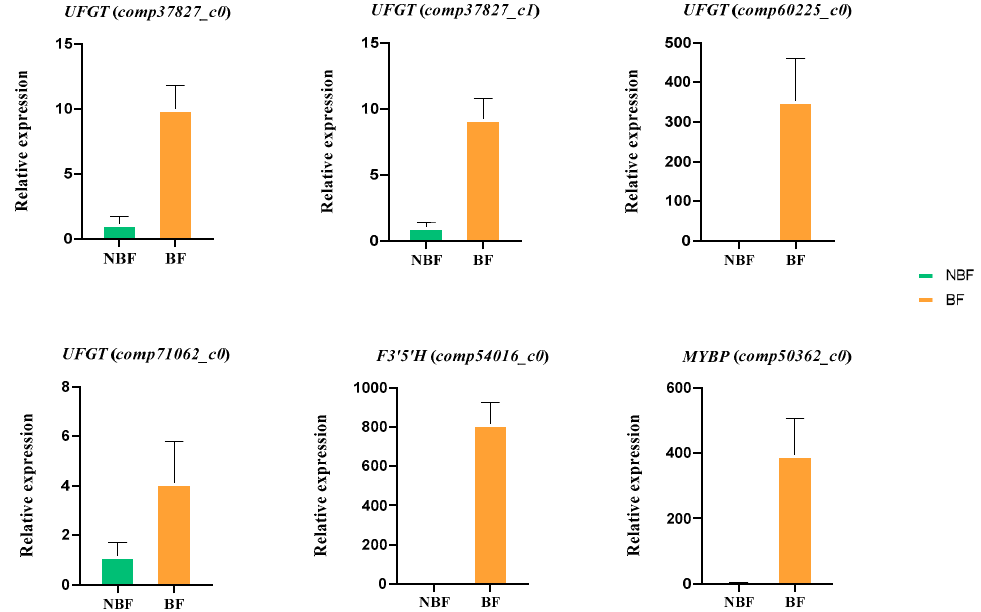
Figure 5. Expression patterns of differentially expressed genes (DEGs) in anthocyanin biosynthesis pathway. Green represents NBF and yellow represents BF. Data are means ± standard deviations (SD).